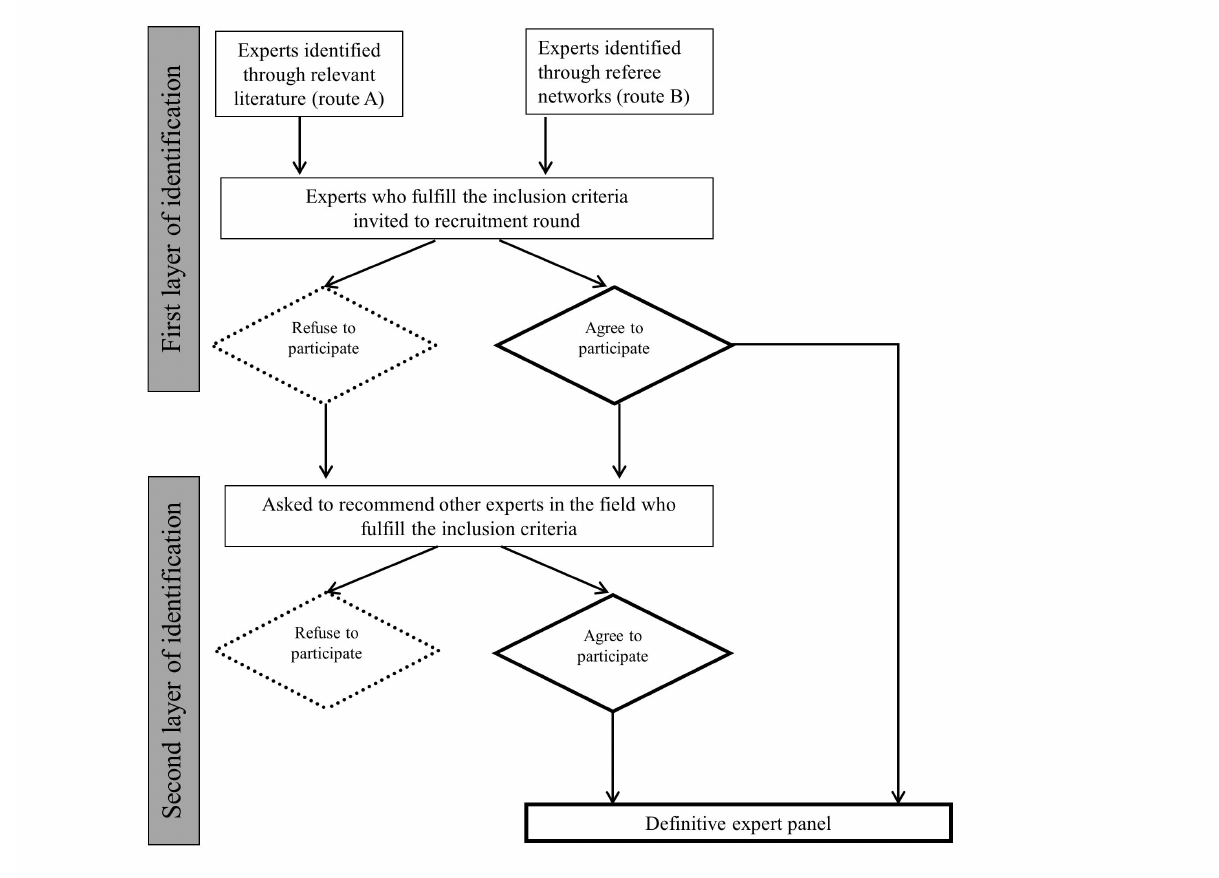
Figure 1. Identification and composition of the expert